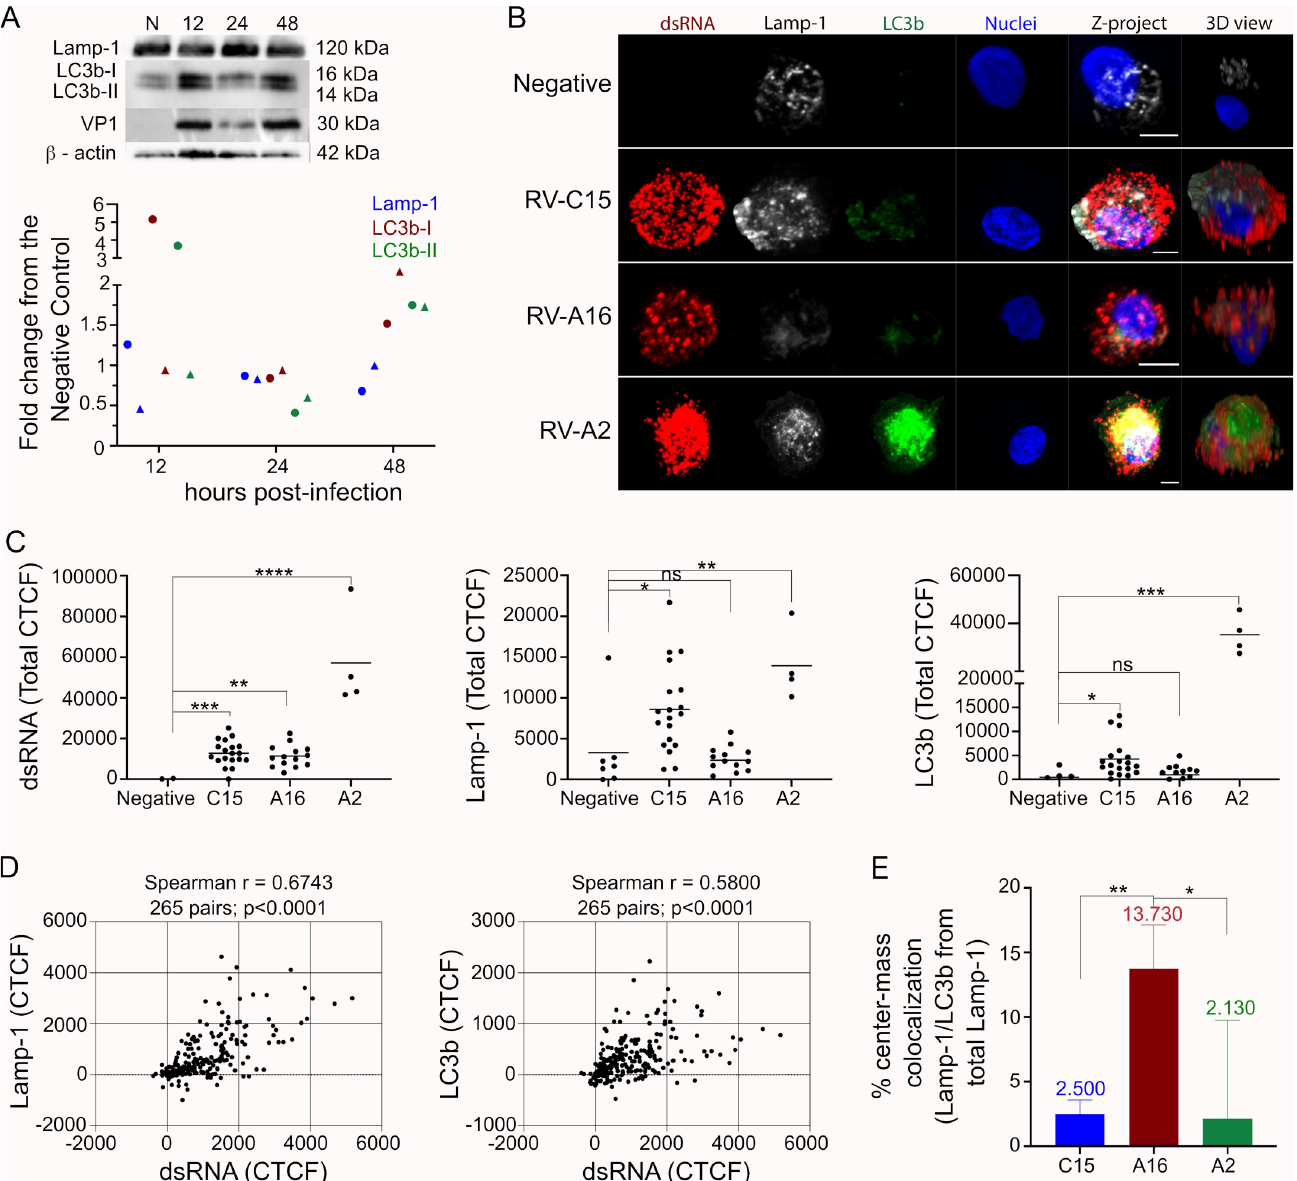
Fig 5. RV-C15 replication induces incomplete autophagy in HAE at 12hpi. A: Fold change graph represents Lamp-1, LC3b-I, and LC3b-II protein levels normalized to the endogenous control (actin) and compared to non-infected cultures. Data shown are from two independent donors, represented by circles and triangles. Blot above is from the donor represented by triangles, including the detection of VP1 protein of RV-C15. B: Detection of Lamp-1 (gray), LC3b (green) and dsRNA (red; nuclei, blue) in non-infected HAE and HAE infected with RV-C15, RV-A16, or RV-A2 by immunofluorescence at 12hpi (z-stacks at 1 μ m of thickness; scale bar = 5 μ m). C: Quantification of fluorescence levels (CTCF) for Lamp-1, LC3b, and dsRNA in non-infected and RV-infected (dsRNA+) HAE at 12hpi. Dots represent the total CTCF per cell and the line indicates the mean. Statistical analysis was done by Kruskal-Wallis test following Dunn’s multi- comparison test ( � p < 0.05, �� p < 0.01, ��� p < 0.001, ���� p < 0.0001, ns = non-significant). D: Spearman correlation analysis (two-tailed; 0.95% confidence interval) between fluorescence levels for dsRNA and Lamp-1 or LC3b in RV-C15-infected HAE at 12hpi. Each dot represents the fluorescence levels of dsRNA and Lamp-1 or LC3b quantified in the same Z-slice. E: Spatial colocalization analysis of Lamp-1/LC3b colocalization in RV-C15, RV-A16, and RV-A2 -infected (dsRNA+) HAE at 12hpi. The median colocalization ratio value is plotted top of each bar (bar = median with 95% confidence interval); statistical analysis done by Kruskal-Wallis test following Dunn’s multi-comparison test( � p < 0.05; �� p < 0.01).